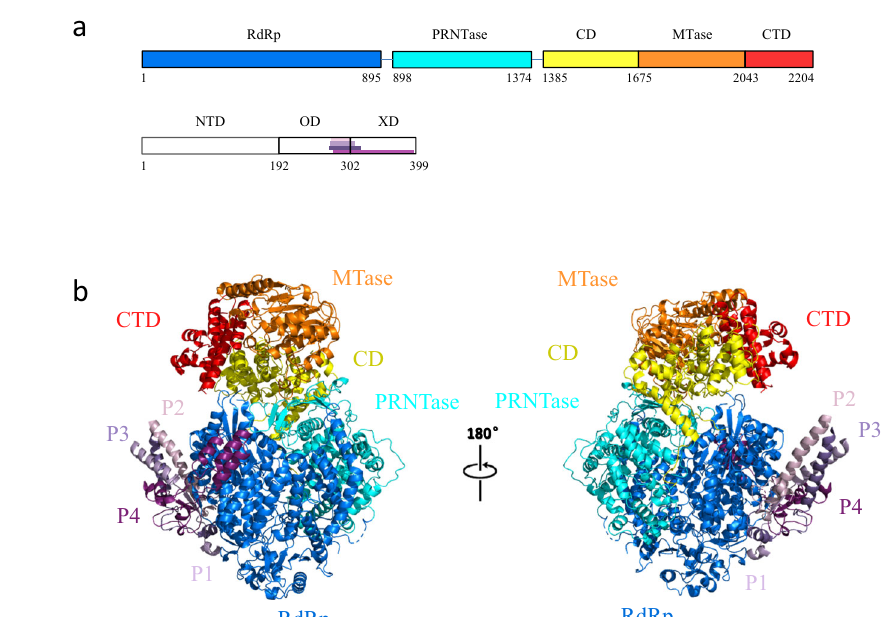
Fig.2|OverallstructureofNDVL-Pcomplex.a Schematicdiagramofthedomain architecture of NDVL protein divided into fi ve parts: RdRp(blue), PRNTase (cyan), CD (yellow), MTase (orange), and CTD (red). NDV P protein is divided into three parts:NTD, OD,and XD.EachdomainofNDVLisrepresentedusing aunique